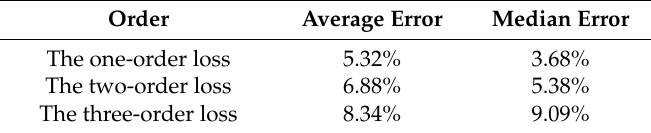
Table 4. The estimation errors of measurement loss with different orders.